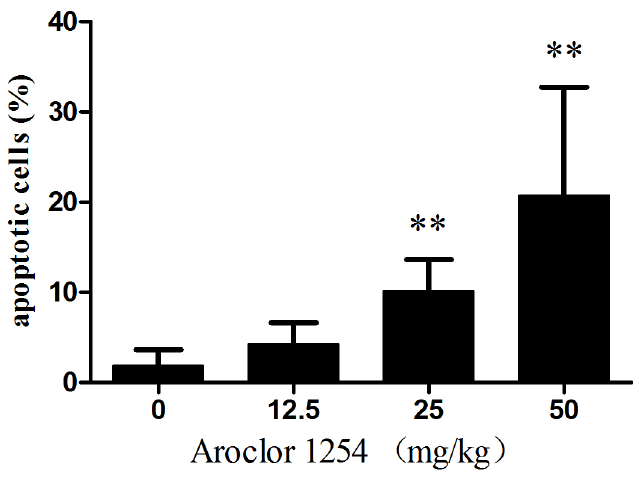
Figure 5. Effects of Aroclor 1254 exposure on apoptosis incidence in mouse cumulus-oocyte complexes. ** Compare to control group, P ,